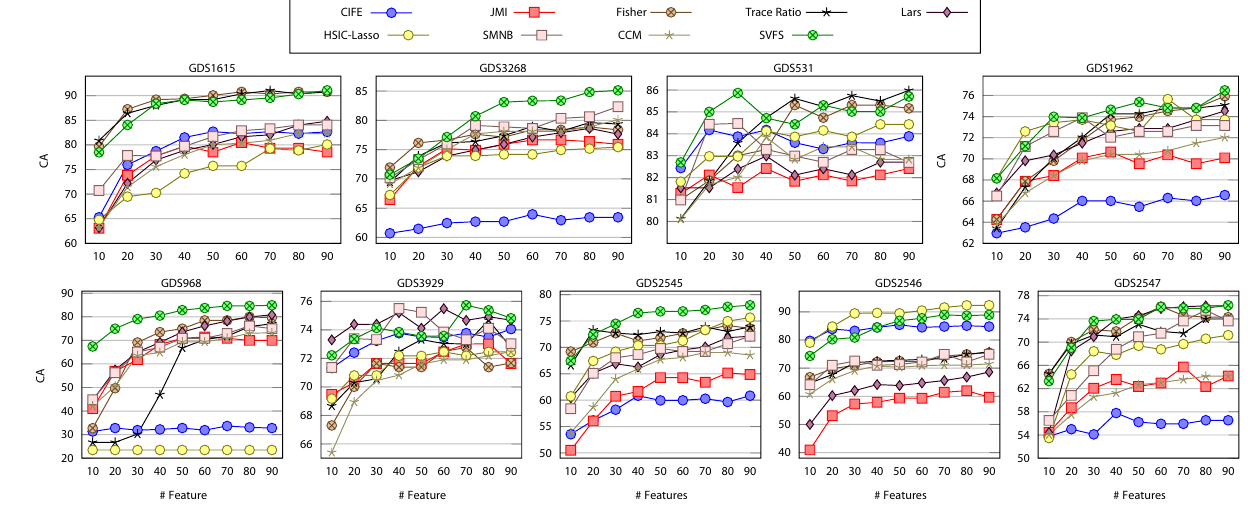
Figure 5. Average classification accuracy of feature selection by CIFE, JMI, Fisher, Trace Ratio, Lars, HSIC- Lasso, SMNB, CCM and SVFS over 10 independent runs on genomic datasets.